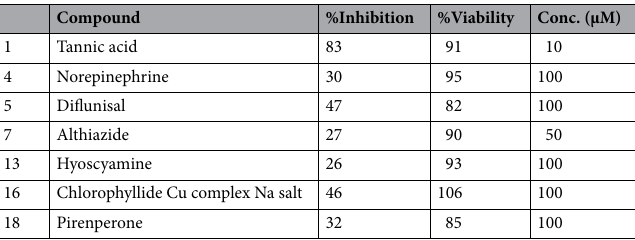
Table 2. Seven final αSyn aggregation inhibitor candidates identified by the two-step screening.